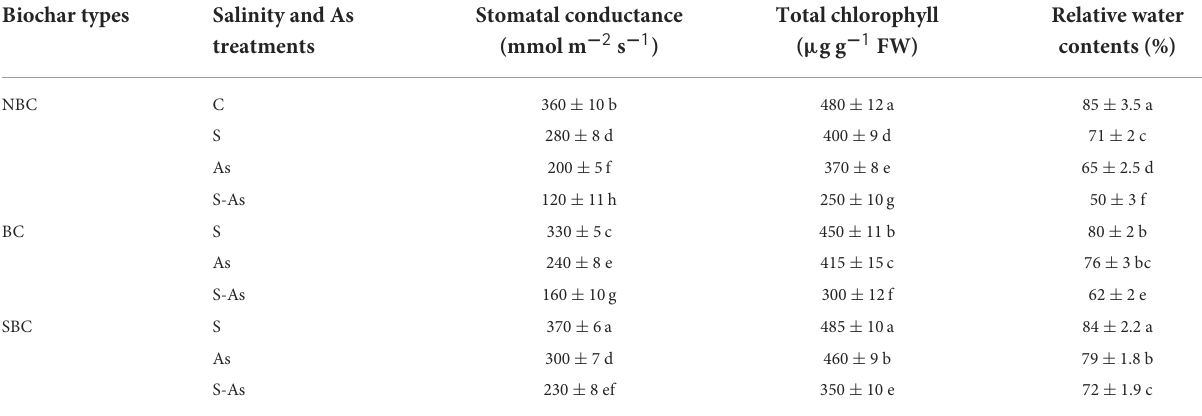
TABLE 2 Effect of salinity, arsenic, and their combination on physiological attributes of quinoa supplemented with no biochar (NBC), biochar (BC), and silicon-nanoparticles doped biochar